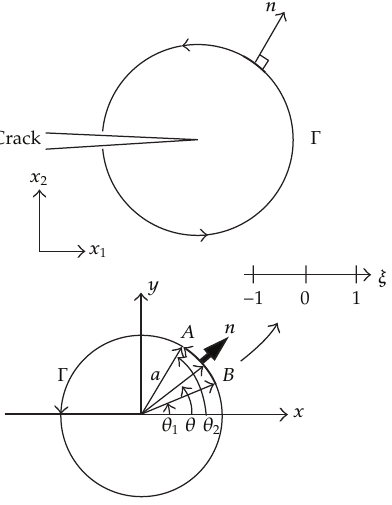
Figure 7: Integrating path used for J integral calculation (cid:6) 24 (cid:7) . Table 3: F (cid:2) a/W (cid:3) for point loaded specimens (cid:6) 27 (cid:7) .